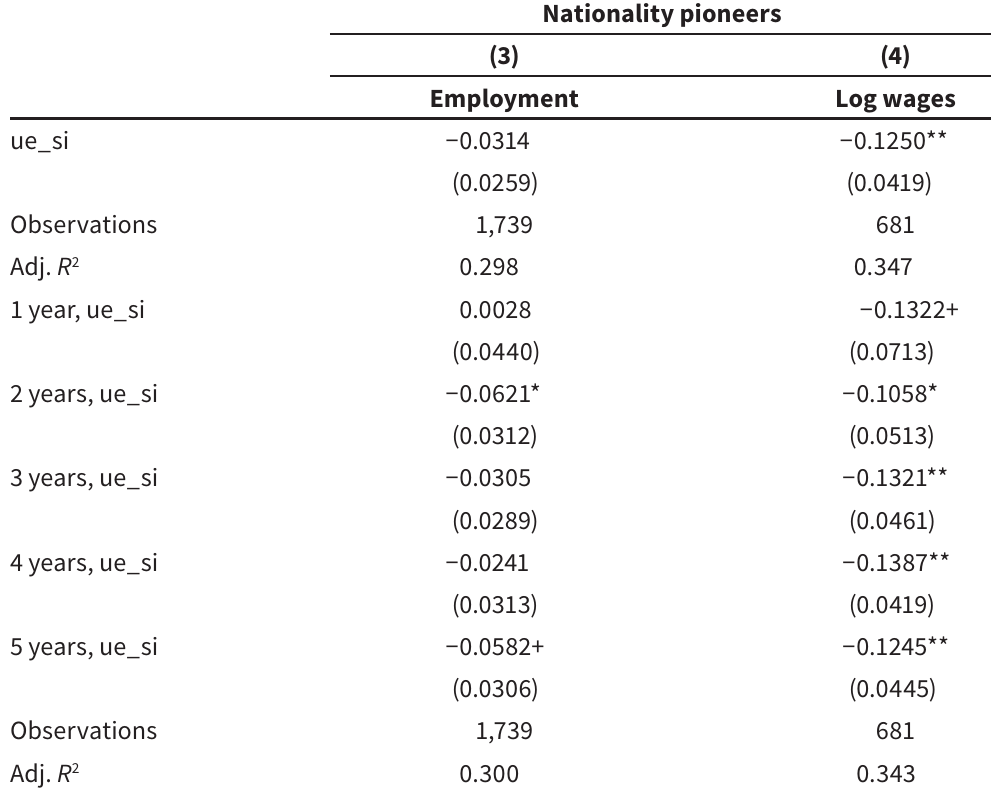
State unemployment estimates using